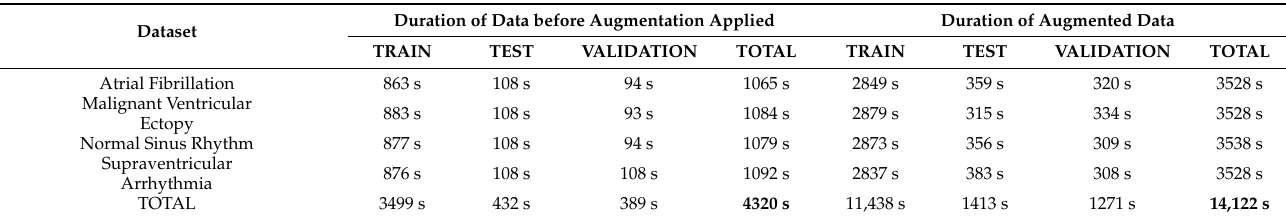
Table 2. Illustration of data augmentation outcomes.